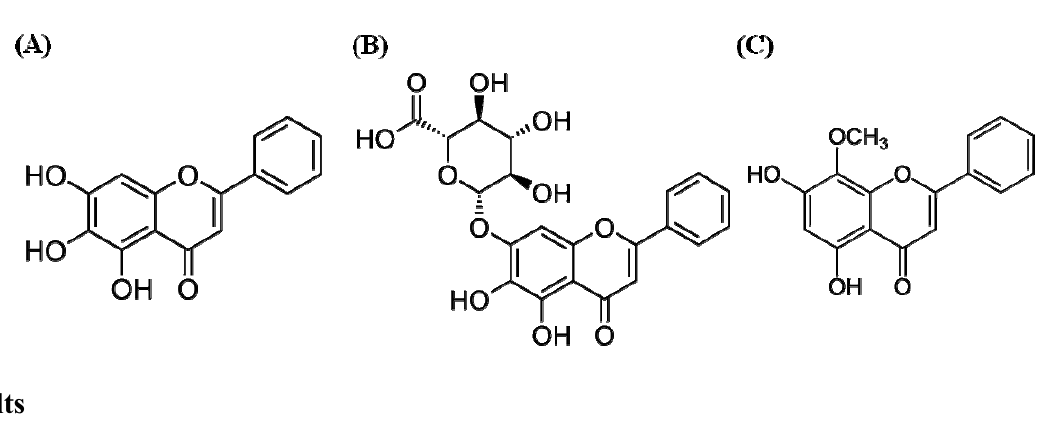
Figure 1. Chemical structures of the active components of skullcap: baicalein ( A ), baicalin ( B ), and wogonin ( C